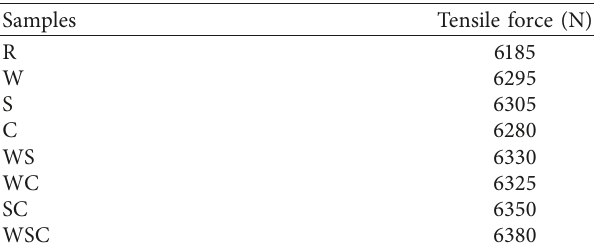
Table 10: Pull-out test